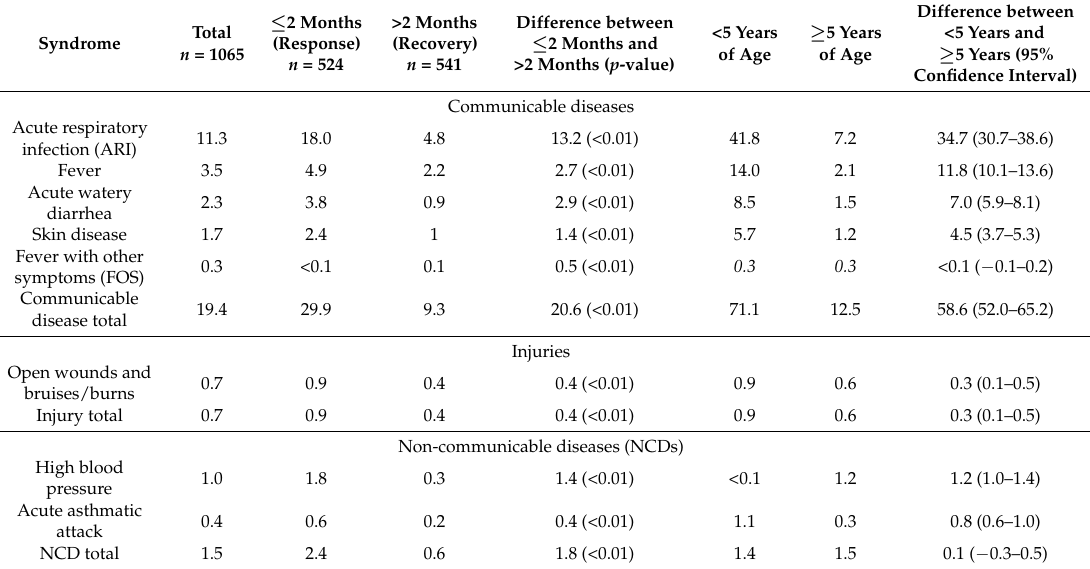
Table 2. Top syndrome rates per 10,000 individuals separated by time post-disaster and by age. Total Syndrome n =